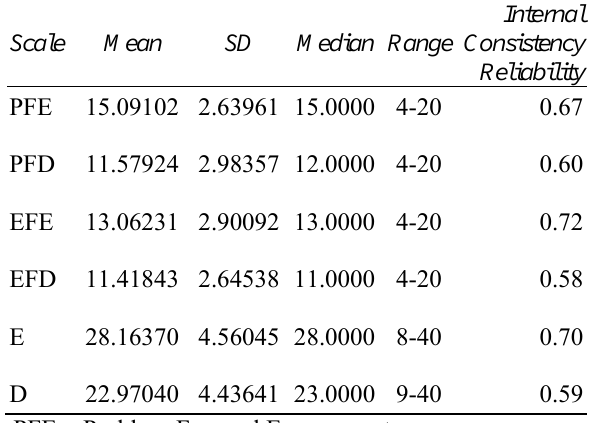
Table 2: Descriptive Statistics and Internal Consistency Reliability of Scales of CSI-SF